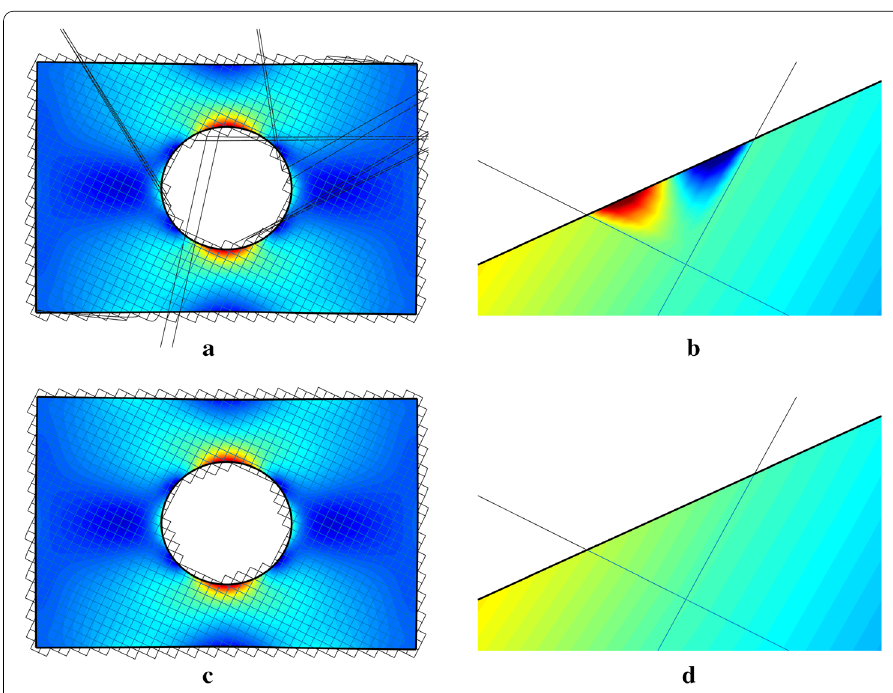
Fig. 8 Displacements and von-Mises stresses from numerical solutions with and without basis removal in the Neumann problem using C 1 Q 2 -splines and mesh size h = 0 . 1. In the detailed view we note poor quality of the stresses on the boundary in the standard solution which is remedied when removing the problematic basis function. a Standard solution. b Detail in standard solution. c Basis removal solution. d Detail in basis